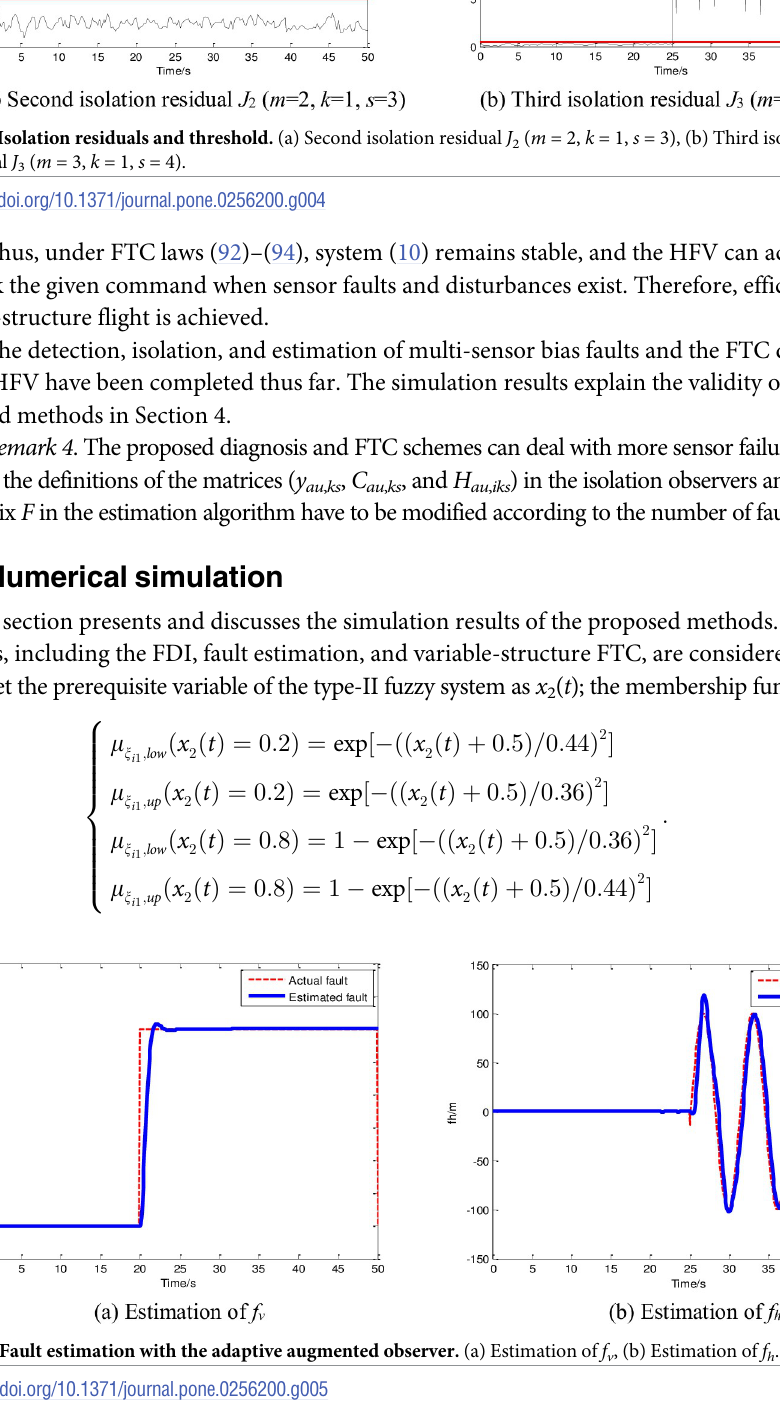
Fig 5. Fault estimation with the adaptive augmented observer. (a) Estimation of f